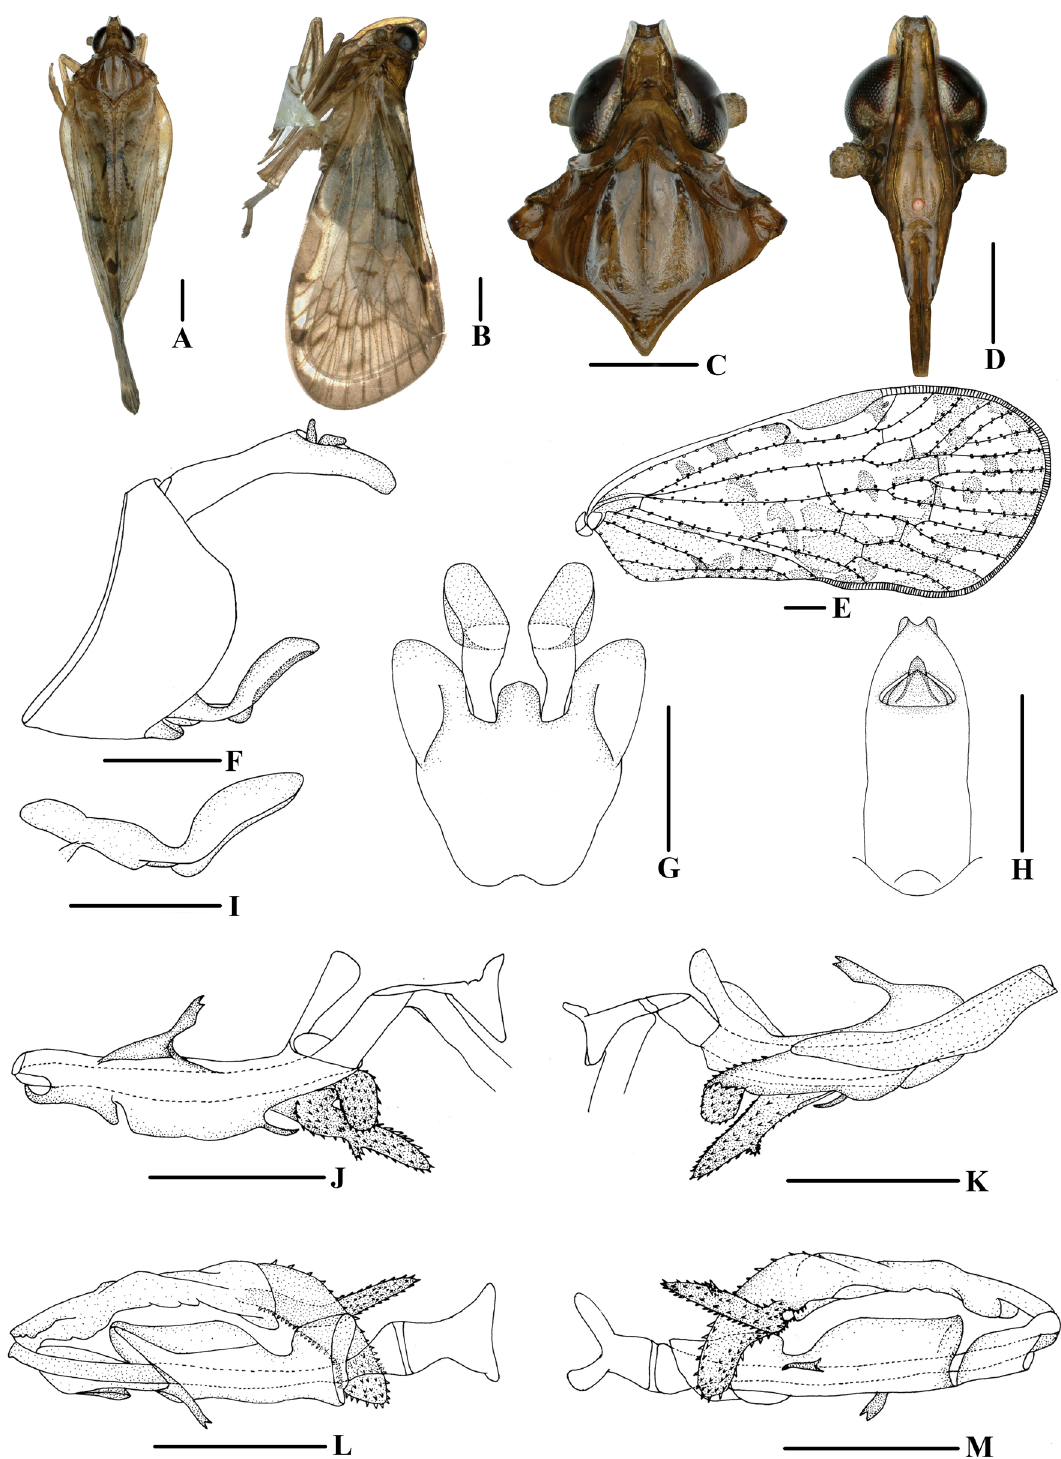
Fig. 5. Andes furcutus Wang, Zhang & Chen sp. nov., ♂. A . Dorsal view. B . Lateral view. C . Head and thorax, dorsal view. D . Face, ventral view. E . Forewing. F . Genitalia, lateral view. G . Pygofer and gonostyli, ventral view. H . Anal segment, dorsal view. I . Gonostyli, lateral view. J . Aedeagus, right side. K . Aedeagus, left side. L . Aedeagus, dorsal view. M . Aedeagus, ventral view. Scale bars: A–D, F–M = 0.5 mm; E = 1.0